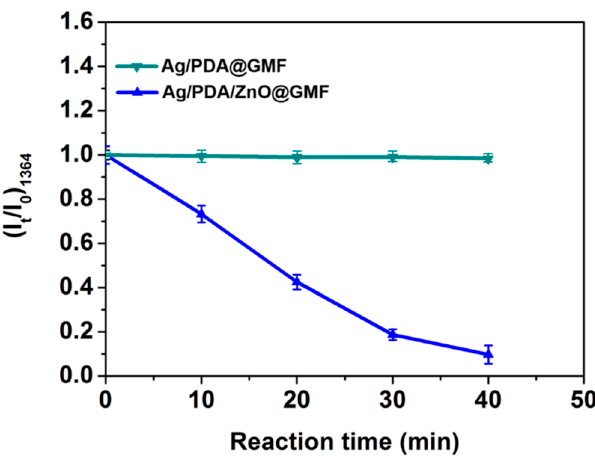
Figure 7. (I t /I 0 ) 1364 vs. reaction time. Both samples had 8 h deposition time of Ag. The blue and green lines are with and without ZnO